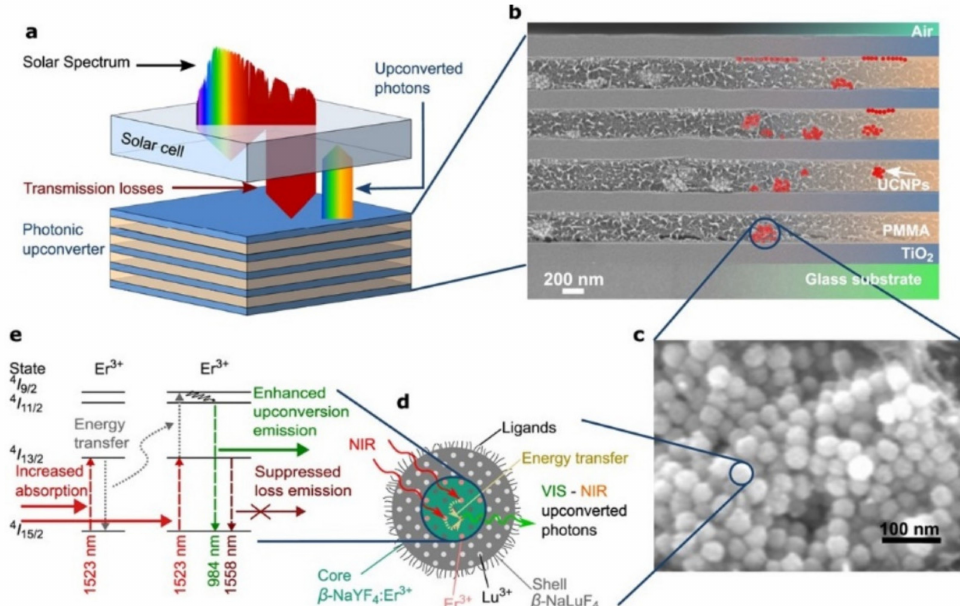
Figure 9. ( a ) Bragg stack (multilayered material comprised of TiO 2 layers/PMMA+NPs) for charge generation in a solar cell by a photonic upconverter. SEM image of the ( b ) Bragg stack and ( c ) of upconverter nanoparticles. ( d ) Scheme of core–shell upconverter NPs, converting near-infrared (NIR) to visible (VIS) photons in the core. ( e ) Energy levels in the upconverter Er 3+ and the upconversion process [from [57] this work by C.L.M. Hofman is licensed under a Creative Commons Attribution (CC BY